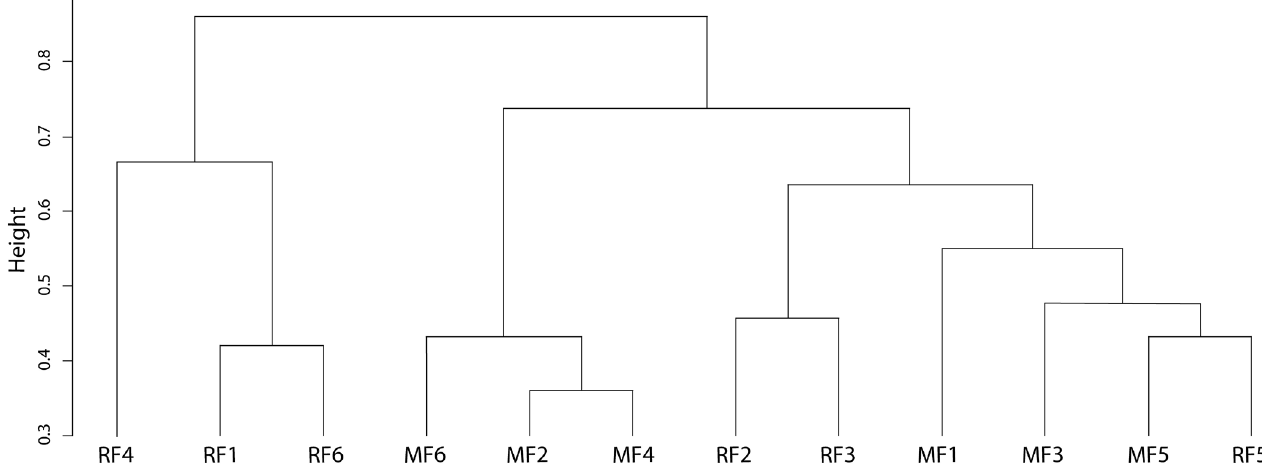
Fig 5. Dendrogram reflecting the similarity between bee composition and sampled sites in the forest fragments of the Atlantic Forest, Paraná, southern